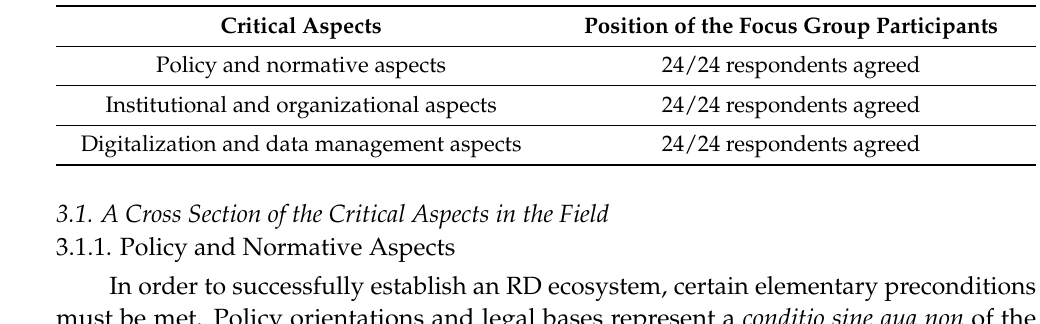
Table 2. Polling results on the identification of the critical aspects in the field of